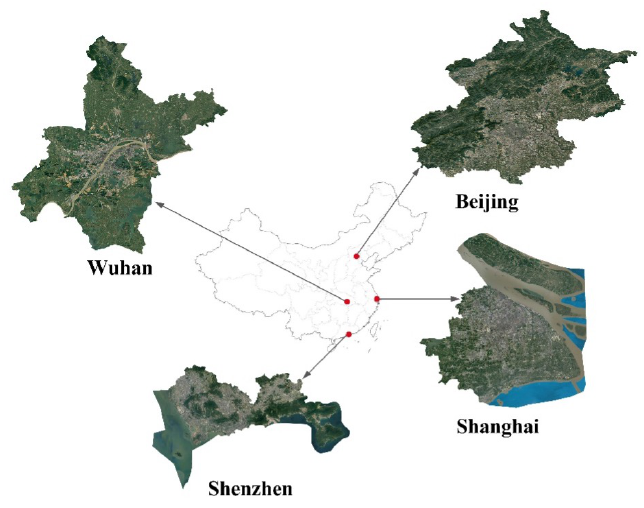
Figure 7. Distribution of the self-annotated building instance segmentation